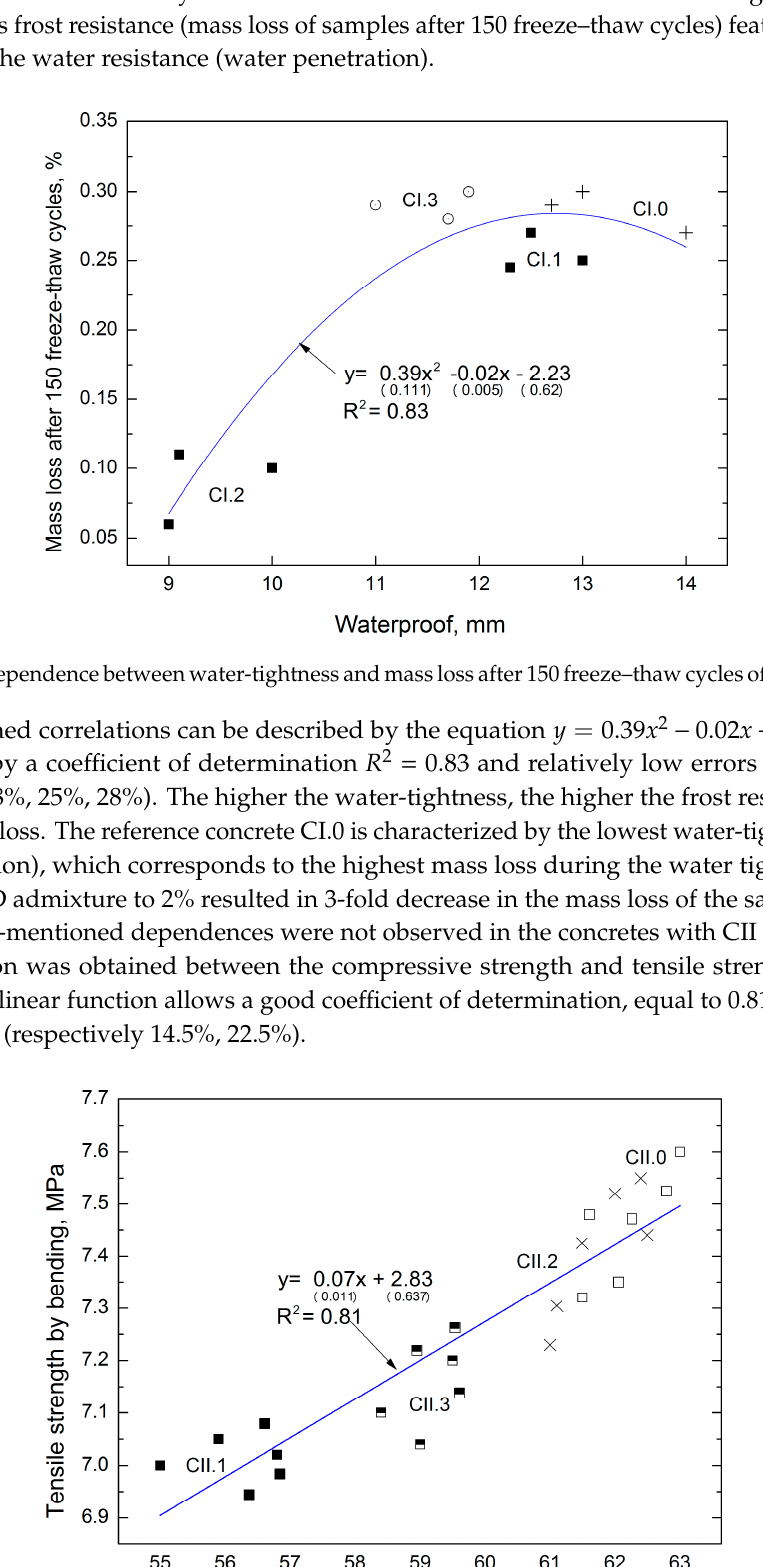
Figure 6. Dependence of splitting tensile strength of CI concrete on A300 micropore content.